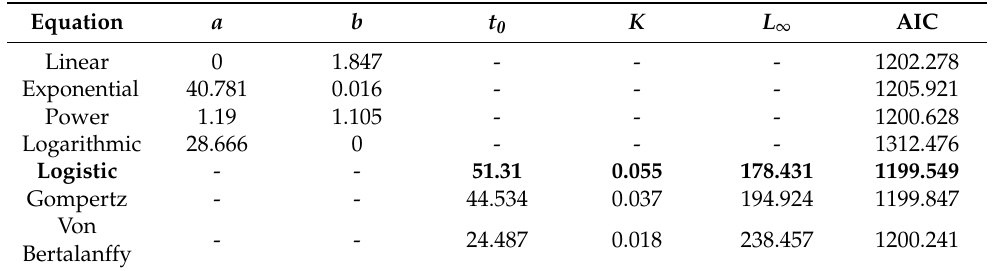
Table 2. Model equation parameters for S. oualaniensis. Bold means the parameters of the best model.